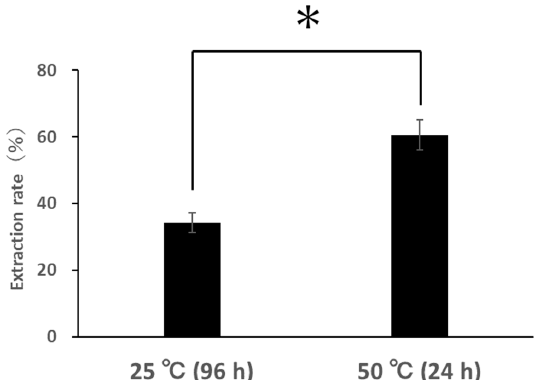
Figure 4. Extraction rate from internal organs of white sturgeon at different temperatures and times. Values are mean ( n = 3). Asterisks mean significant difference ( p < 0.05).